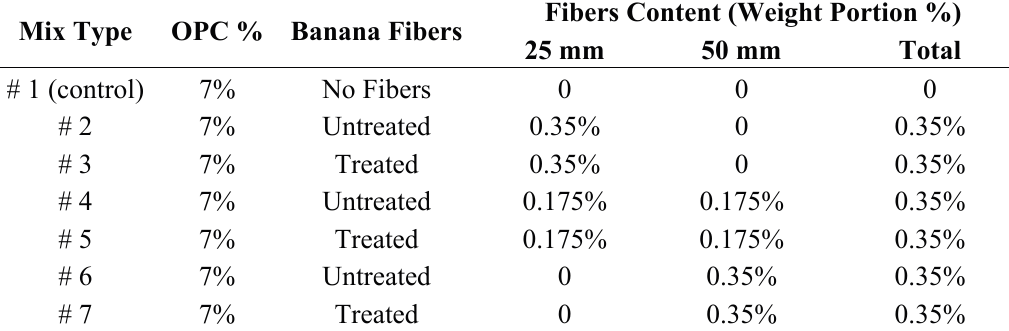
Table 3. Seven design mixes of treated and untreated banana